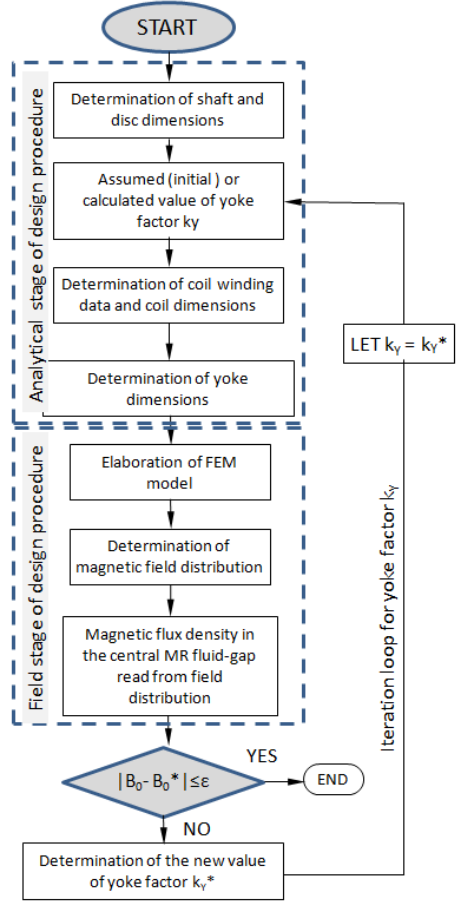
Figure 8. The applied analytical field-design method: block